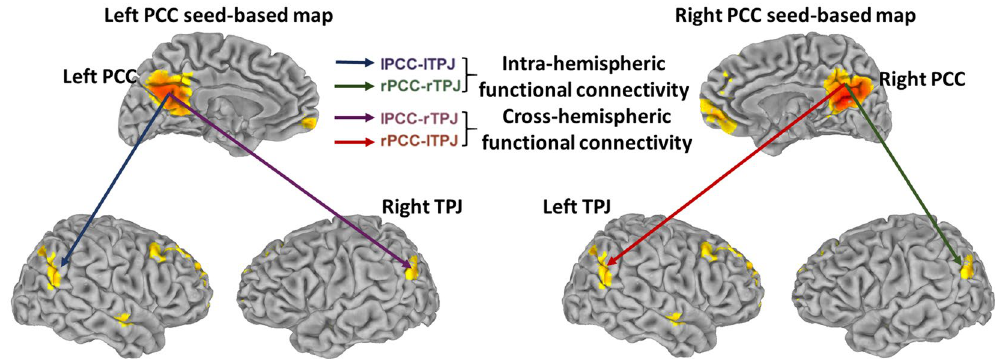
Figure 1. The images show one representative subject’s functional connectivity strength; the region of the PCC was used as the seed for analyzing the following FCSs: the FCS between the left PCC and left TPJ (intra- hemispheric FCS); FCS between the left PCC and right TPJ (cross-hemispheric FCS); FCS between the right PCC and left TPJ (cross-hemispheric FCS); the FCS between right PCC and right TPJ (intra-hemispheric